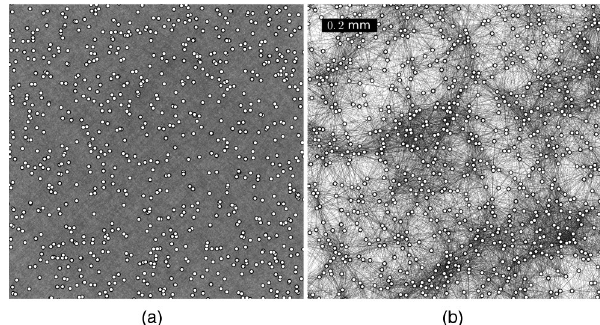
FIG. 2. Cutouts of two random network topologies. (a) Subset of randomly spaced nodes in an ER network with p Note that connections cross the window also from neurons outside of the field of view, such that single connections cannot be distinguished visually in the sketch. (b) 1 . 4 × 1 . 4 mm 2 subset of SC topology generated by axonal-growth rules